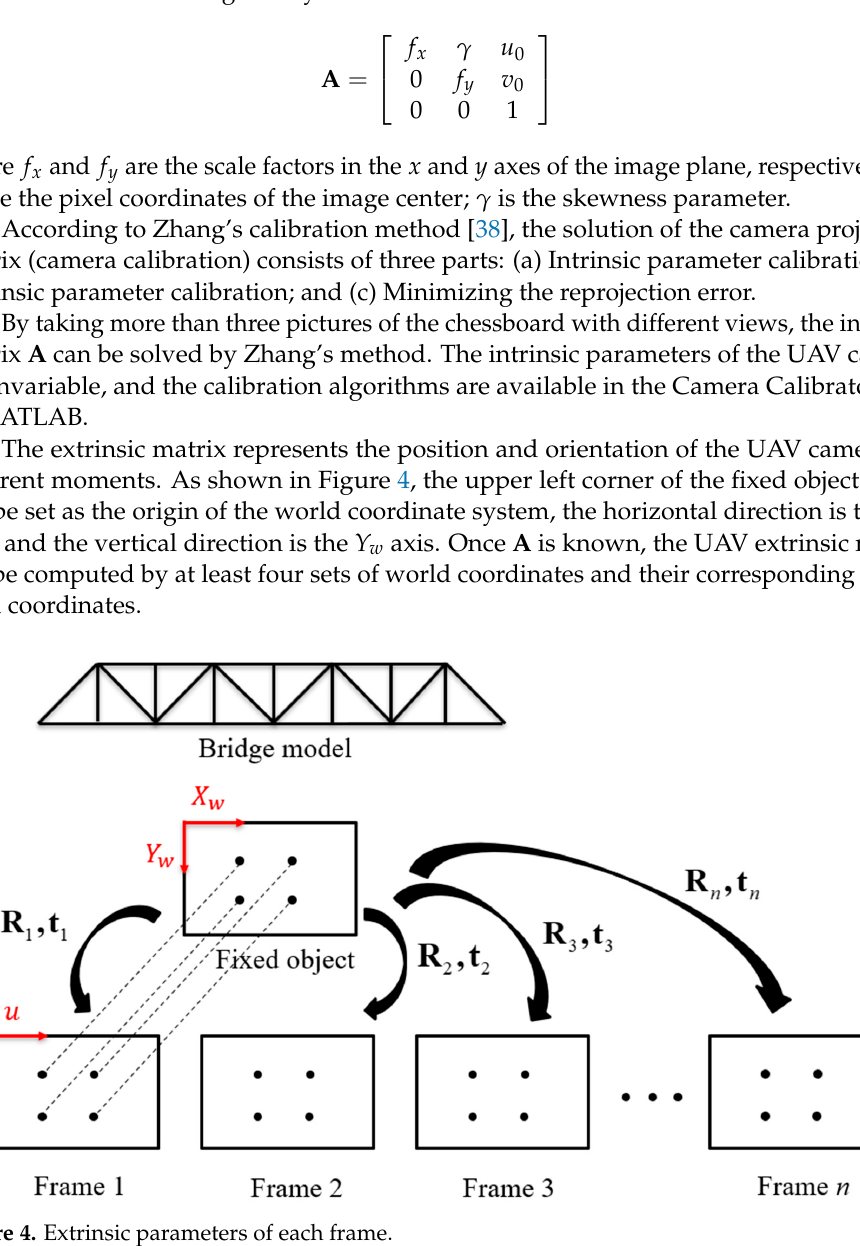
Figure 4. Extrinsic parameters of each frame. During calibration, the extrinsic parameters are estimated numerically by minimiz- ing the reprojection errors for all calibration images, which is: